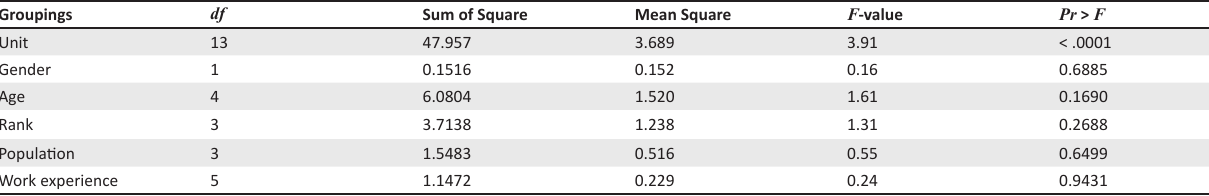
TABLE 17: Factor 2 (People first): Comparison.